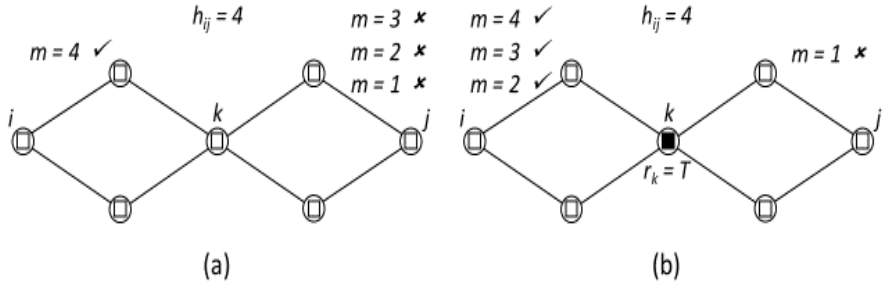
Figure 2. Hops and transmission limits.